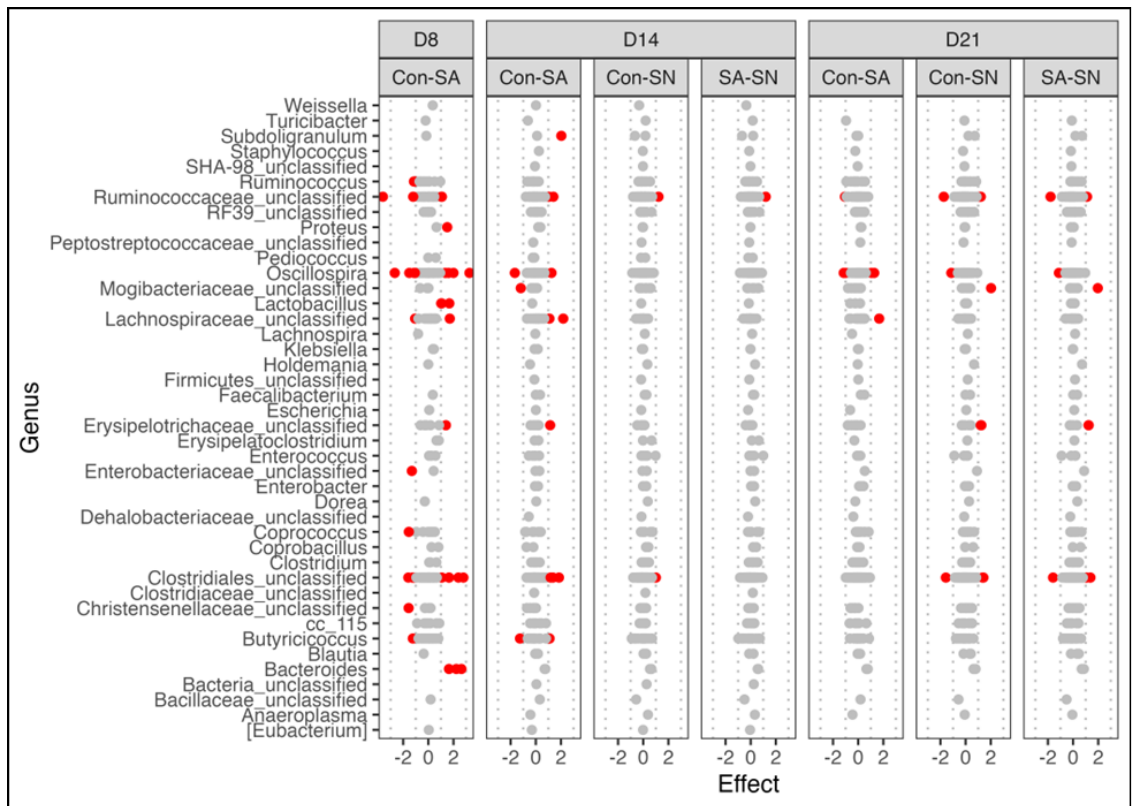
Figure 5. Shifts in the abundance of bacterial features in response to Salmonella colonization. At 7 days of age, control and SA birds were given an oral gavage of PBS or ST, respectively. Following inoculation, five SA birds were moved to pens with uninoculated birds (SN) to act as Salmonella seeder birds for natural horizontal transmission. Changes in the abundance of ASVs were determined using ALDEx2. Genera with features significantly affected in at least one comparison were plotted. Each dot represents the calculated effect size of a single ASV with significantly affected ASVs colored red. Differences were considered significant at FDR <0.05 and effect >1.